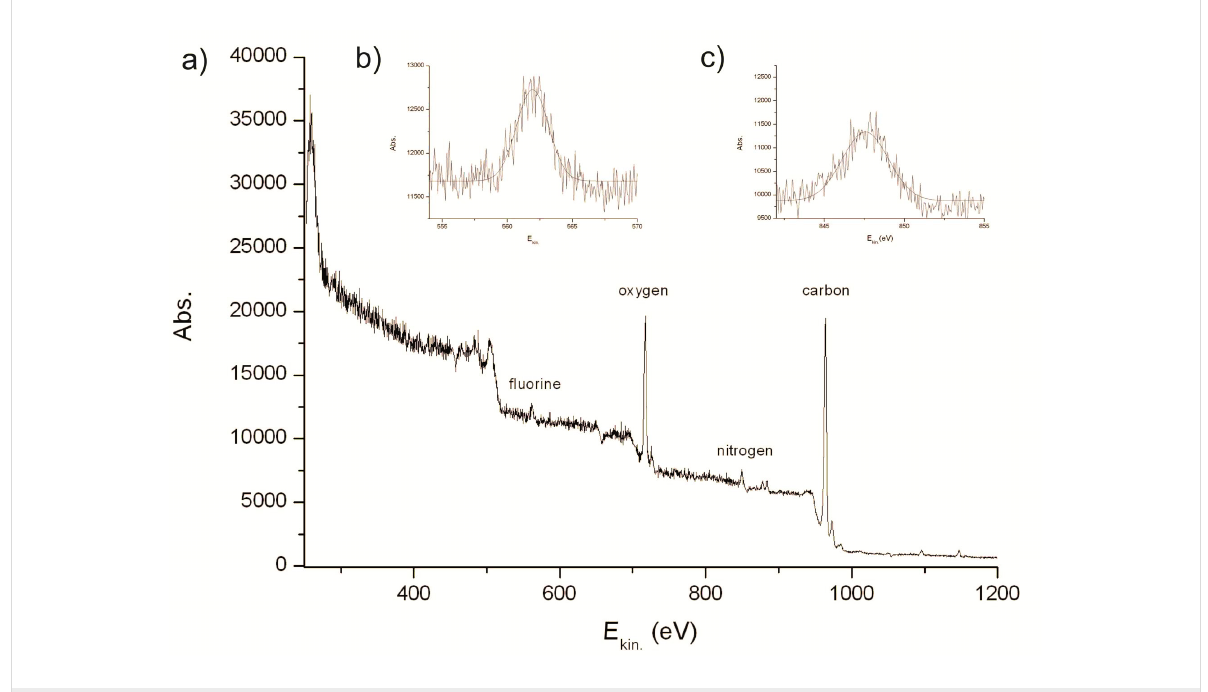
Figure 3: Analyses of functionalized TPX 4 by XPS spectroscopy using h ν = 1250 eV; (a) overview, (b) F 1s core level, (c) N 1s core